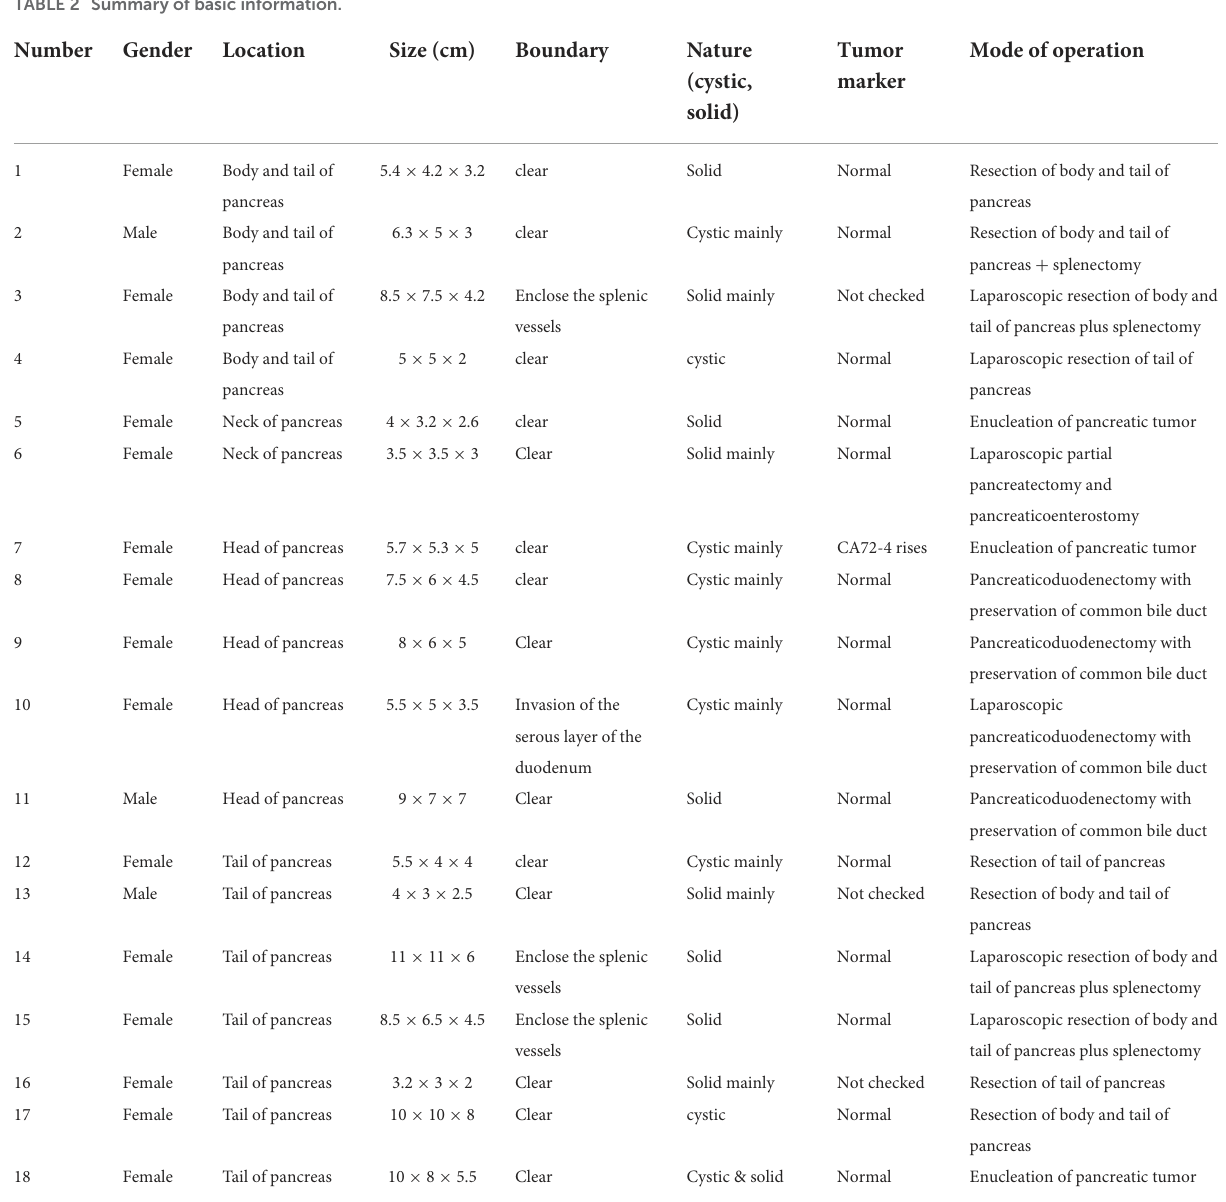
TABLE 2 Summary of basic